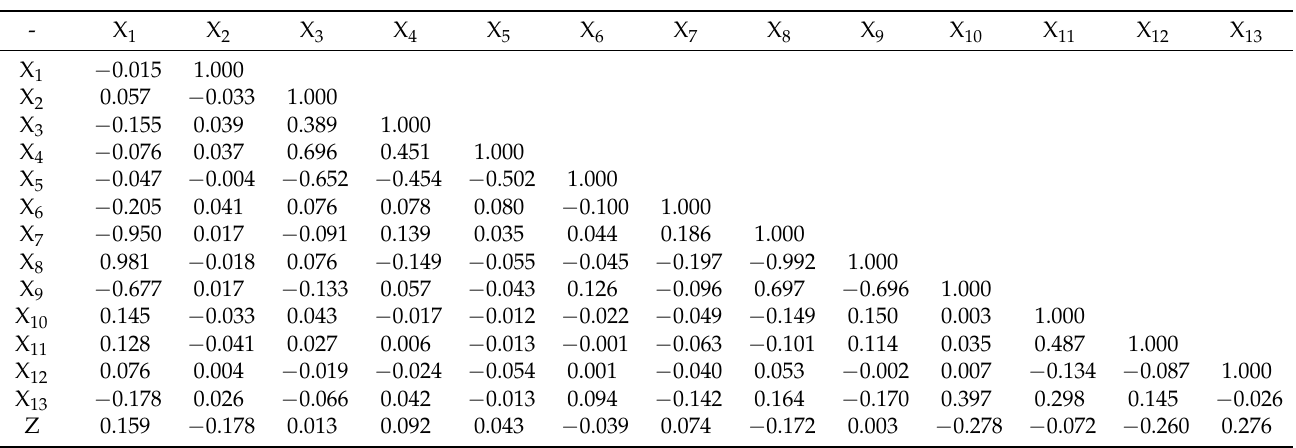
Table 2. Correlation Analysis of the process variables.